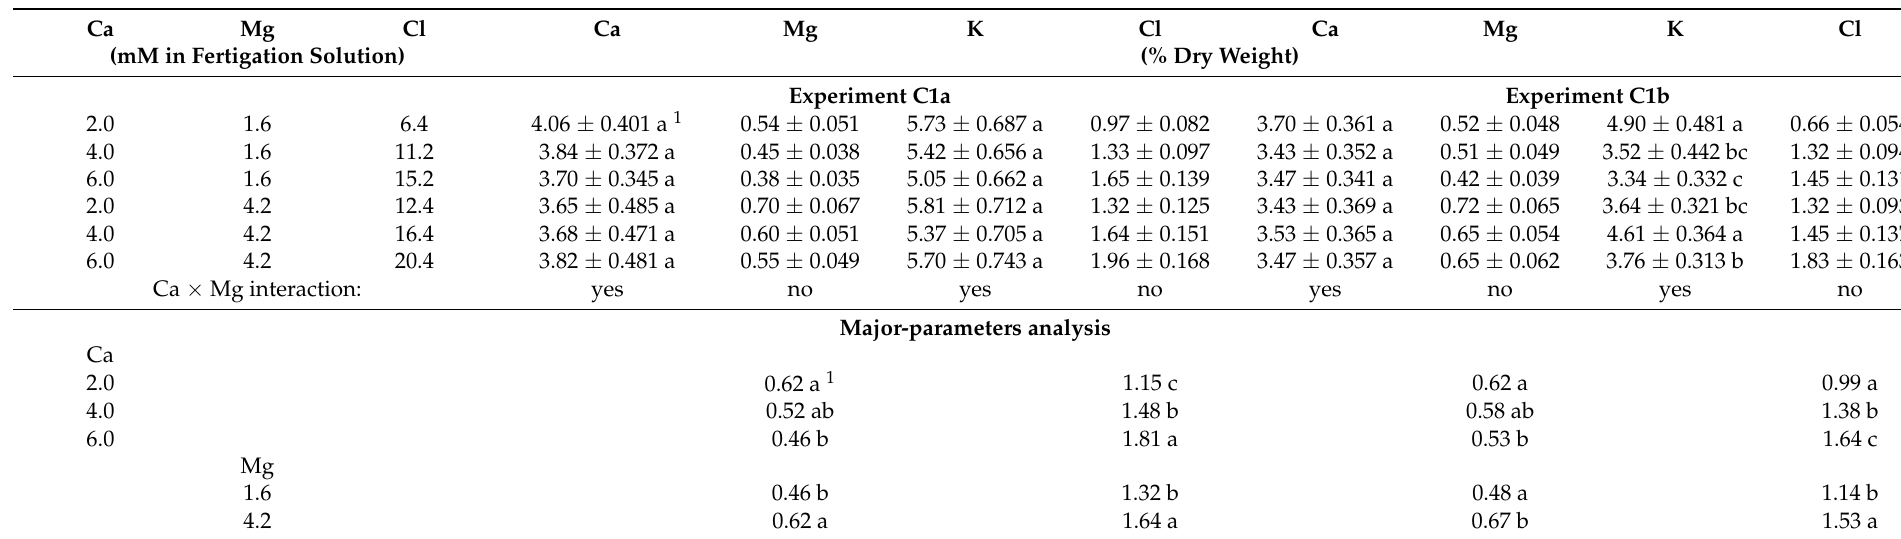
Table 4. Concentrations of nutrients in shoots of sweet basil plants treated with Ca and Mg in the fertigation solution with no foliar-applied K under commercial-greenhouse conditions (Experiment C1, Spring 2015 and Experiment C1b, Autumn